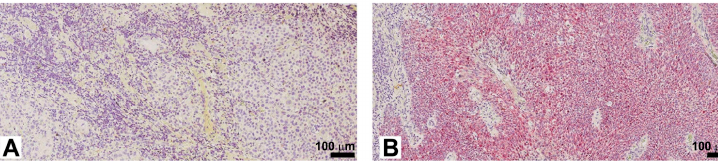
Figure 1. Two representative images of ISH analysis (RNAScope) showing non-actively replicating HPV virus ( A ); and an active replicating HPV virus ( B ). Scale bar: 100 μ m. Table 1. Clinicopathological characteristics of the study population (OP: oropharynx; NOP: non-oropharynx; DOD: dead of disease; W&A: well and alive).